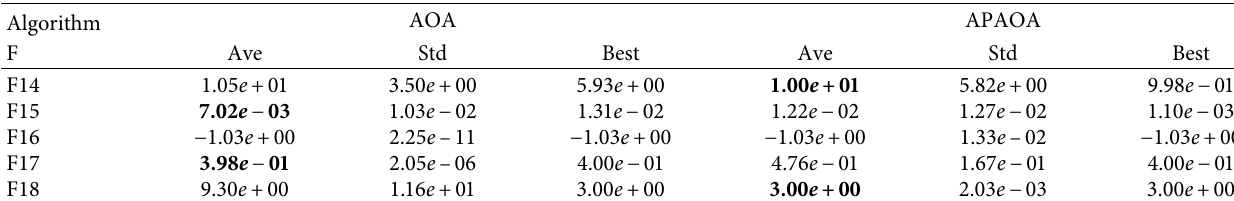
Table 6: Fixed-dimensional multimodal function